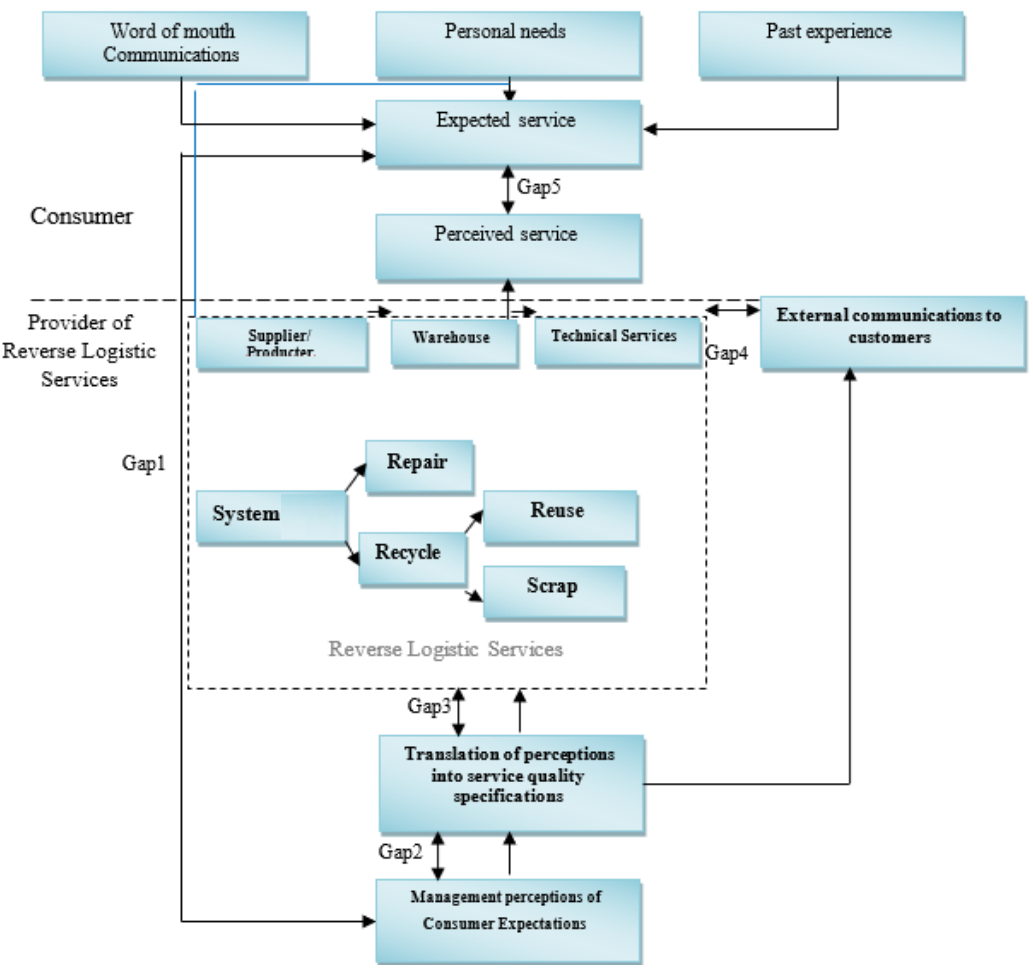
Fig. 1. Extended model of service quality gap analysis